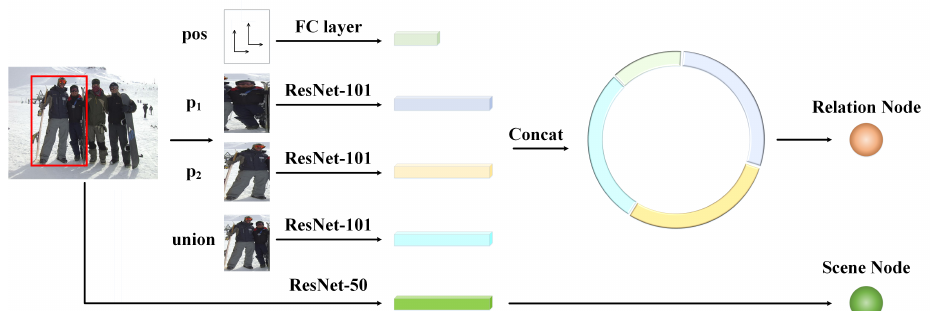
Figure 2. Node generation module. Take two individuals in the red bounding box, for example. The features of their individual bodies, their union and the relative position are extracted to form social relation nodes. As for the scene node, it is generated by the features extracted from the entire